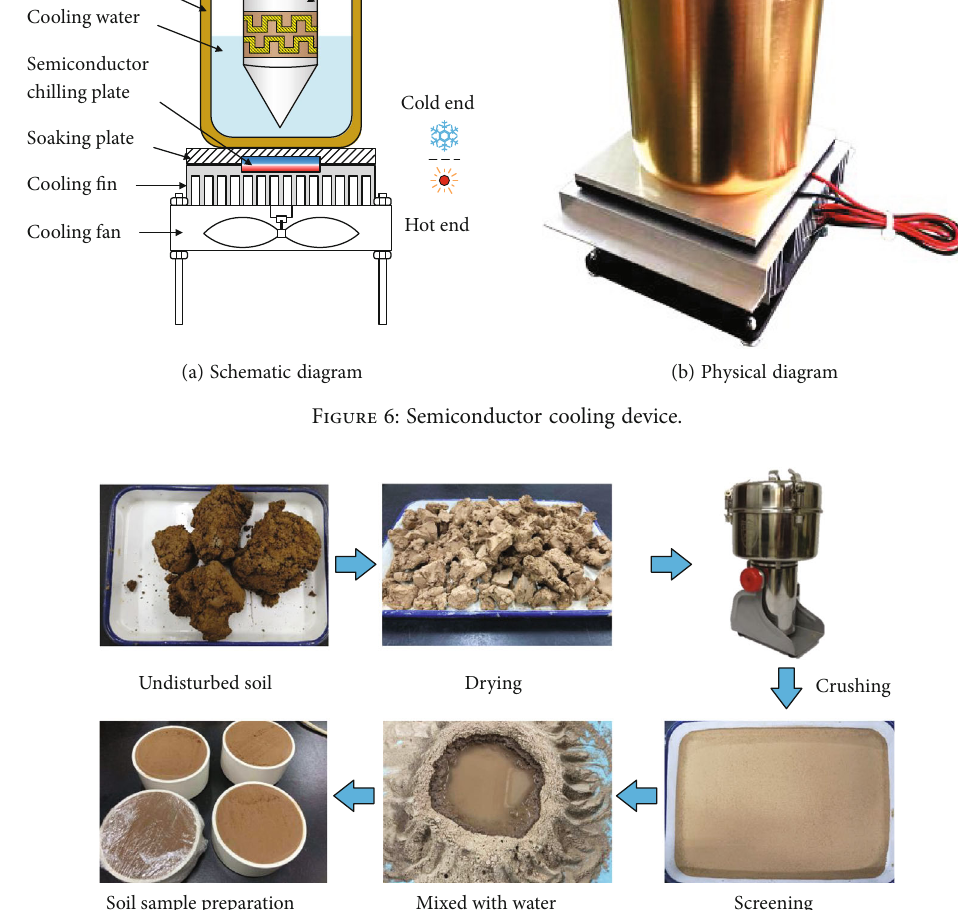
Figure 7: Preparation of test soil